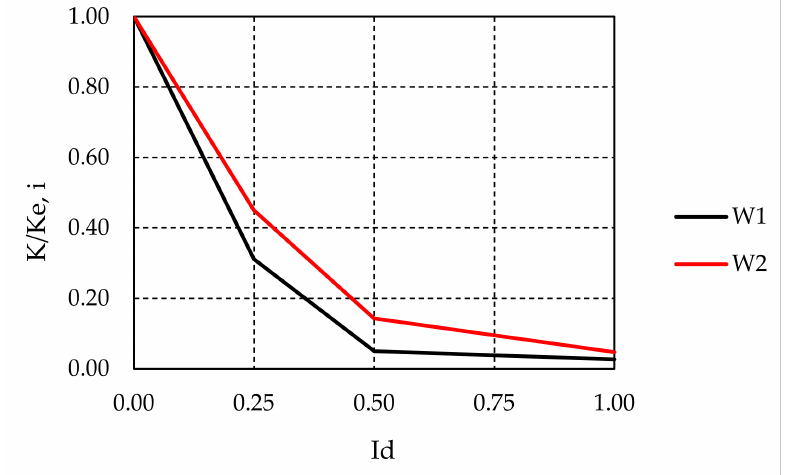
Figure 14. Degradation of elastic stiffness depending on the damage index for W1 and W2. Table 4. Degradation of shear resistance for repeated loading for W1 and W2.